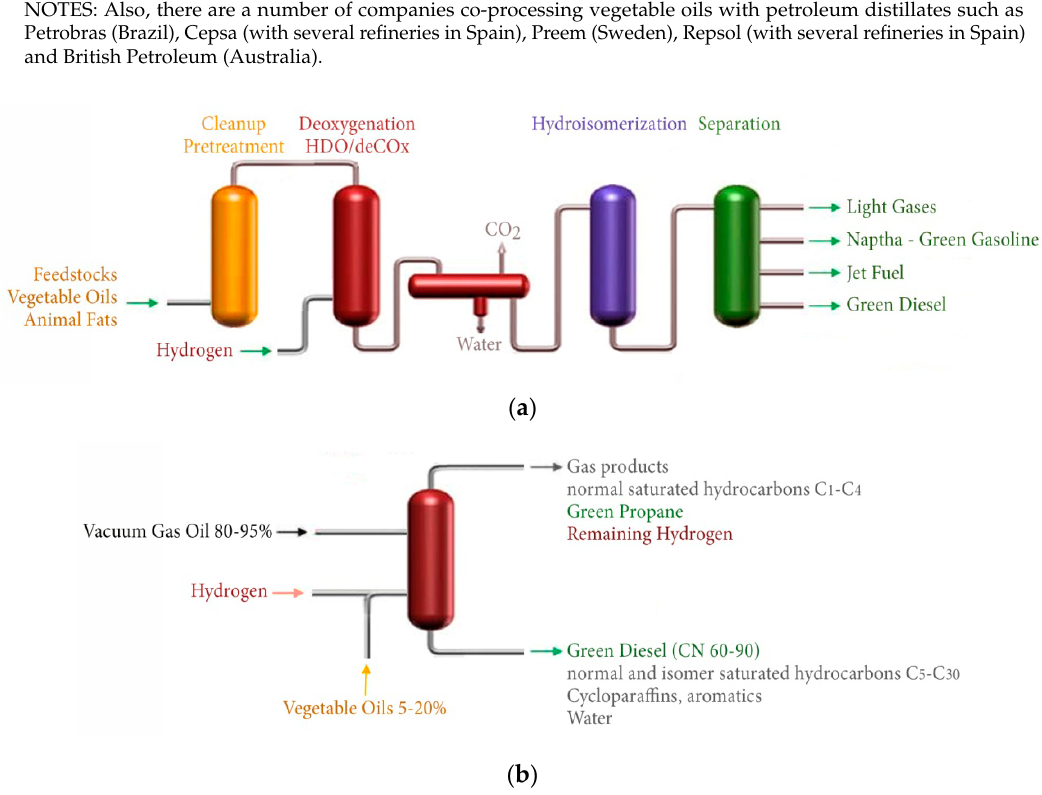
Table 4. List of the main green diesel producers currently in operation. Data from [62].